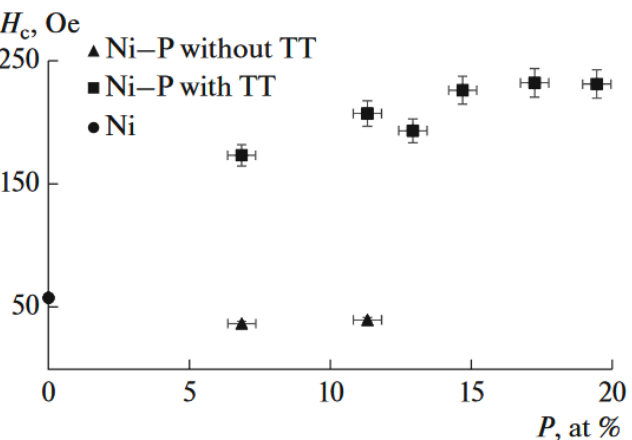
Figure 4. Effect of the phosphorus content on the coercive force of Ni–P coatings in the initial state and after thermal treatment relative to the coercive force of pure nickel. Reproduced from [7] with permission from Pleades Publ.,